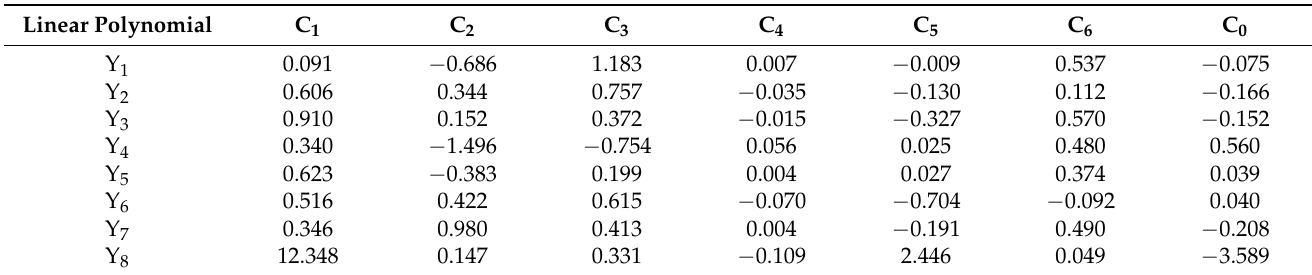
Table 5. The parameters of linear